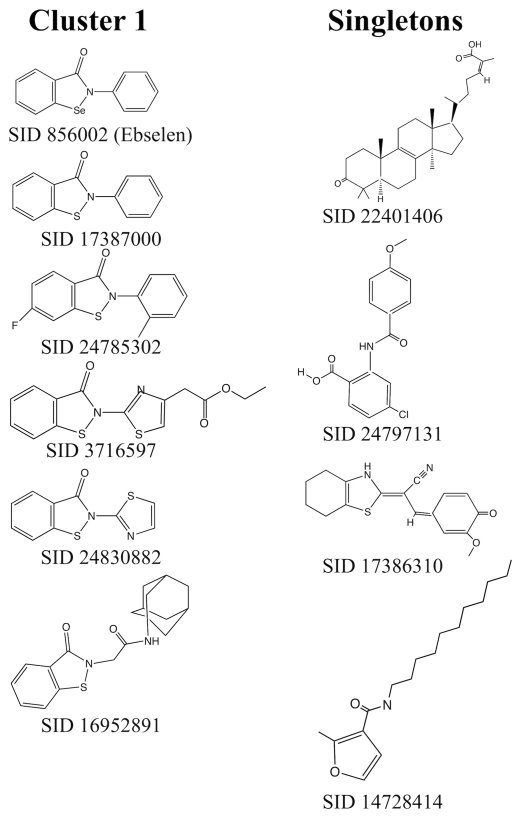
Structures of the cluster 1 and singleton HTS hits.